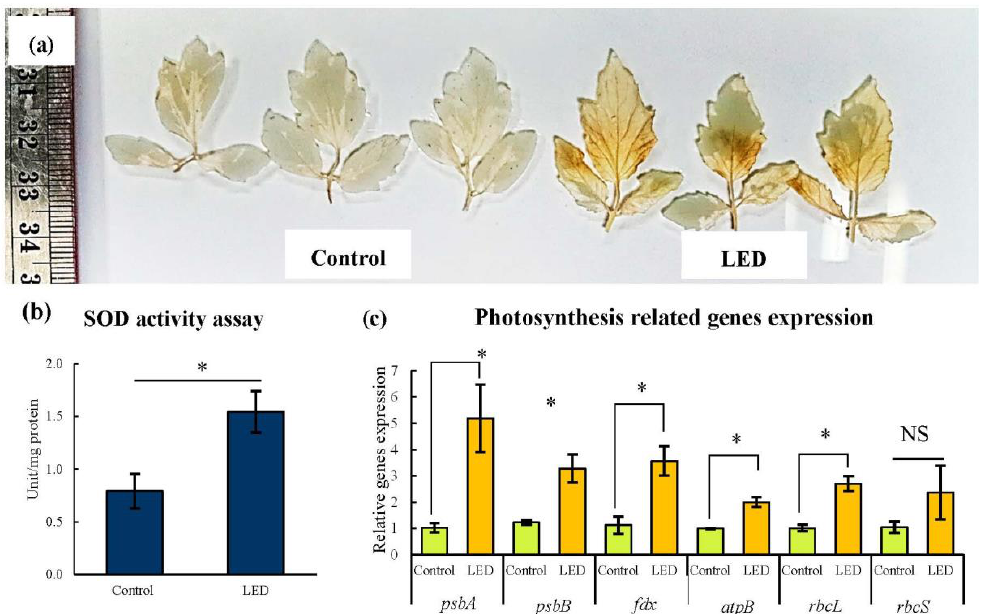
Figure 4. The H 2 O 2 accumulation, SOD activity assay, and photosynthetic gene expression in leaves. The hydrogen peroxide accumulation ( a ), superoxide dismutase activity assay ( b ), photosynthetic- related gene expression ( c ). The tomato seedlings were recorded at 14 days after planting. Mean and standard error are calculated from three replicates, the symbol of * indicates significance, and the symbol of NS indicates a non-significant effect at p ≥ 0.05 .